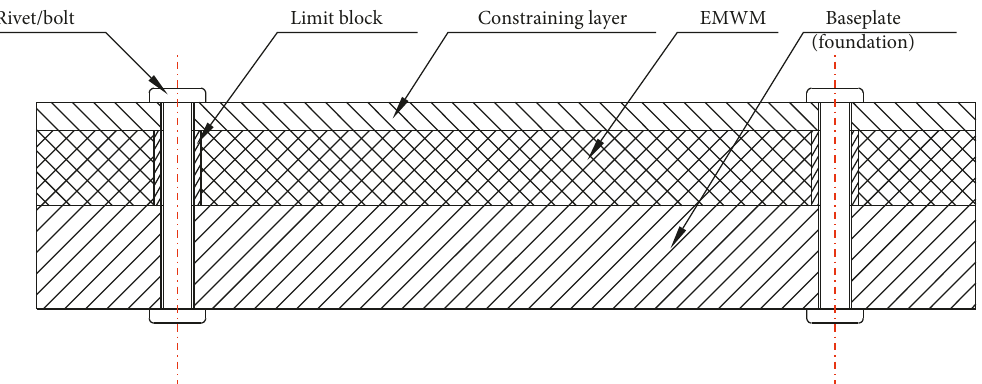
Figure 3: Two-dimensional schematic diagram of the EMWM insertion damping